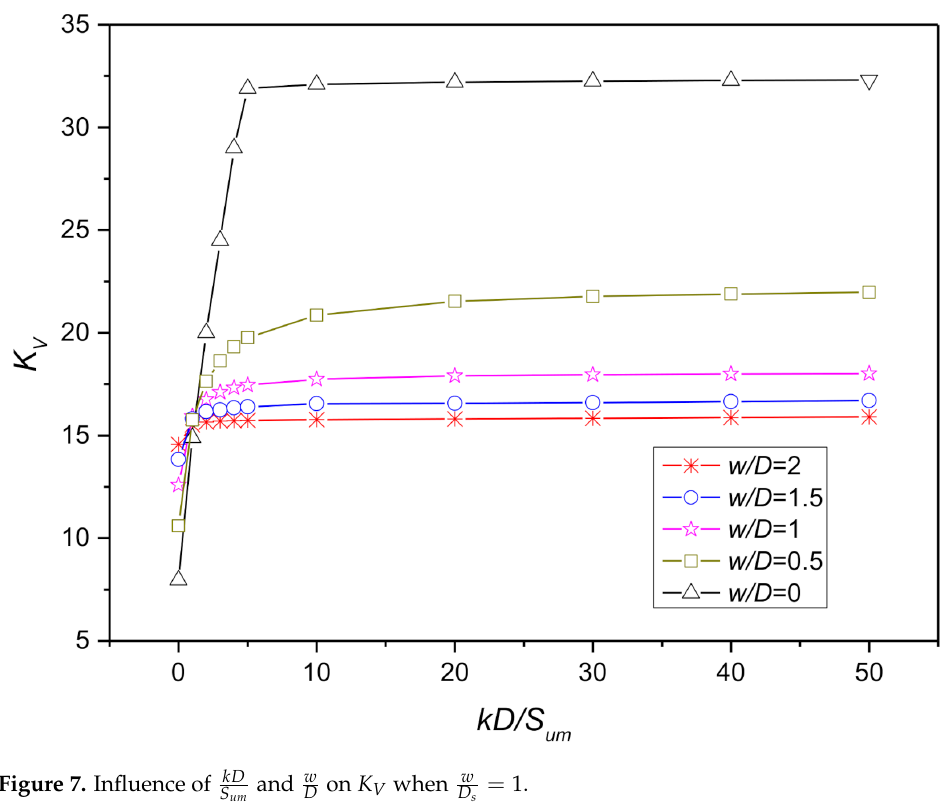
on K V when w and w D S um